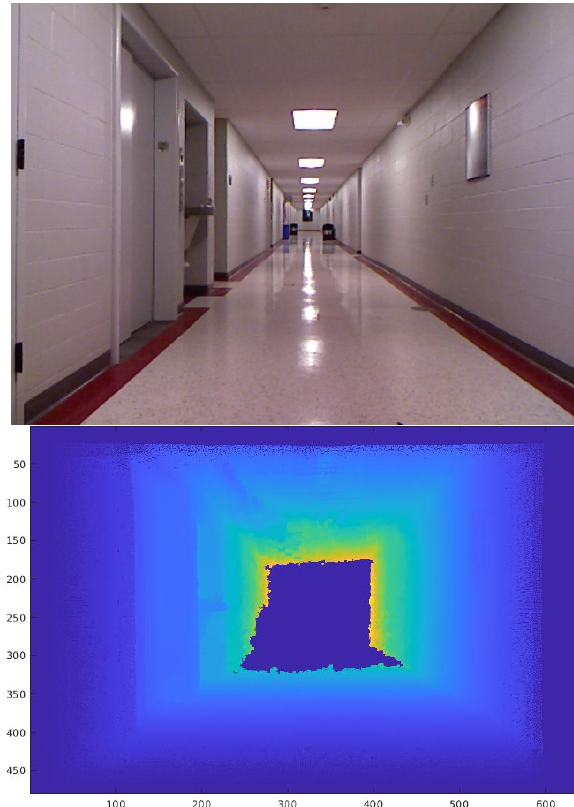
Figure 6. Stored RGB image (top) and corresponding depth map (bottom).